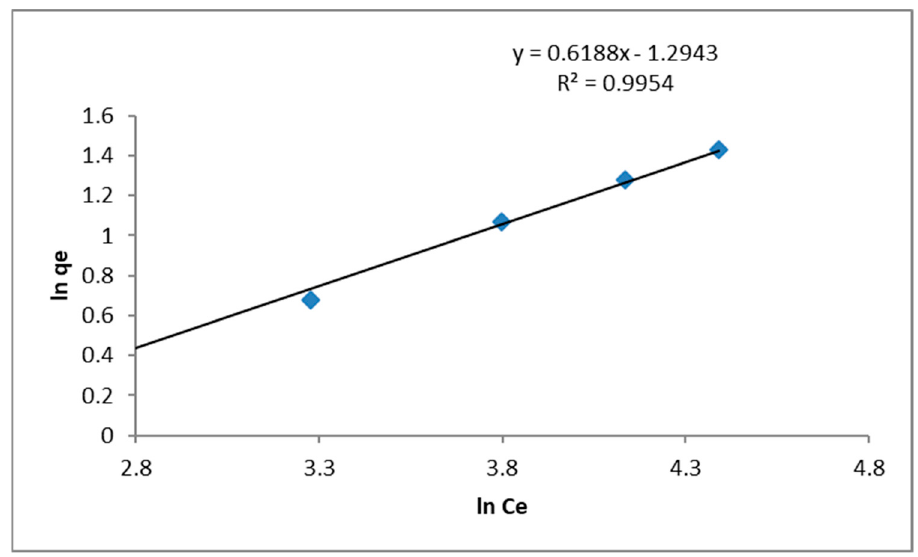
Figure 10. Freundlich Isotherm for CDs.